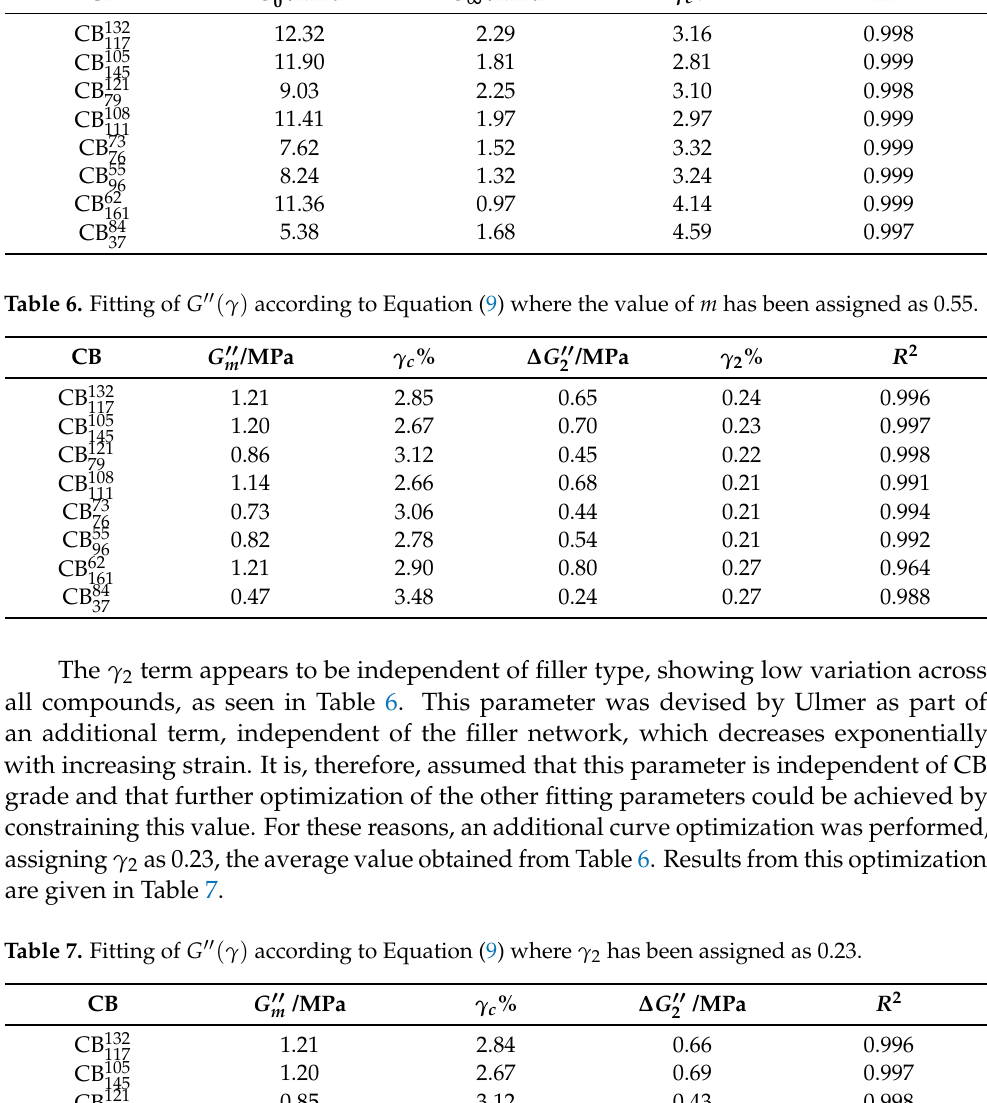
Table 5. Fitting of G (cid:48) ( γ ) according to Equation (5) where the value of m has been assigned as 0.55. CB G (cid:48) /MPa G (cid:48) ∞ /MPa γ c % R 2 0 12.32 CB 132 117